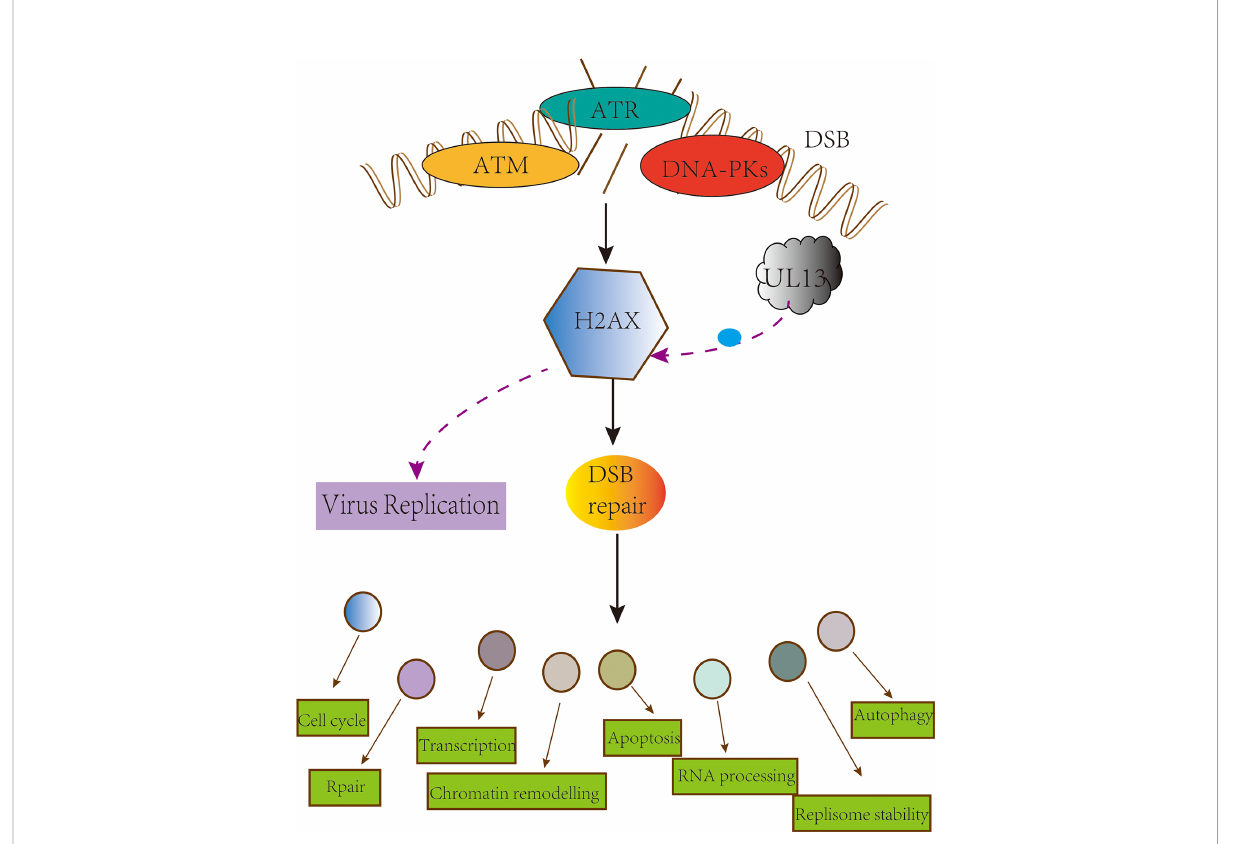
FIGURE 4 pUL13 phosphorylates H2AX to promote viral replication. The conserved herpesvirus Protein kinase pUL13 regulates DNA damage marker H2A histone family member X (H2AX), and pUL13-mediated H2AX phosphorylation plays a pivotal role in ef fi cient virus replication and progeny